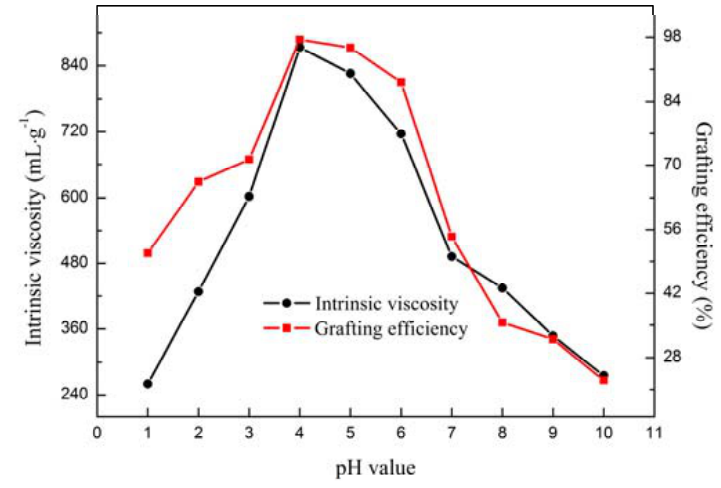
Figure 5. Effect of pH on intrinsic viscosity and grafting efficiency of CPCTS ‐ g ‐ P (CTA ‐ DMDAAC).